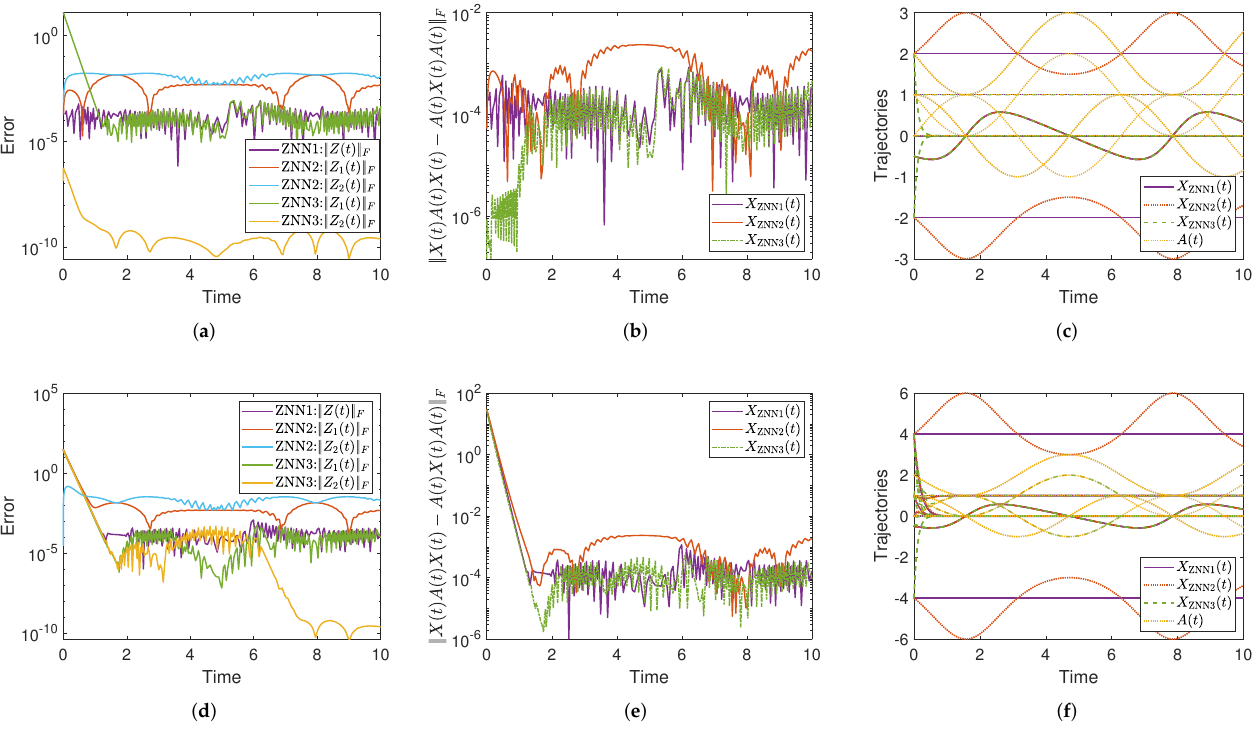
Figure 2. The ZNN error tracking, convergence, and trajectories of the solutions in Section 4.4 under IC1 and IC2. ( a ) Section 4.4 under IC1: ZNN error tracking. ( b ) Section 4.4 under IC1: